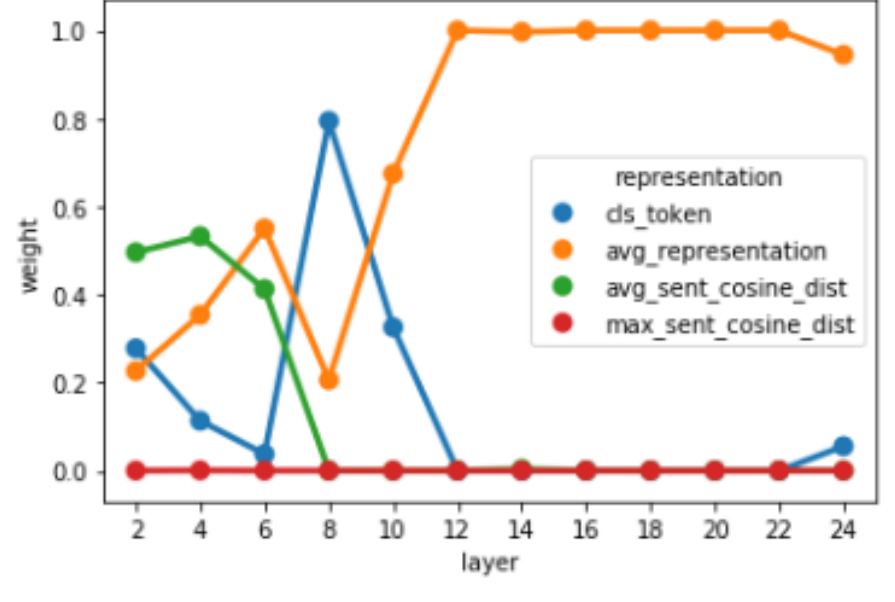
Figure 9. Weights associated with sentence-pair representations of BERT-Large found using NNLS to minimise the distance between a linearly re-combined set of RDMs and the ground-truth model RDM for each